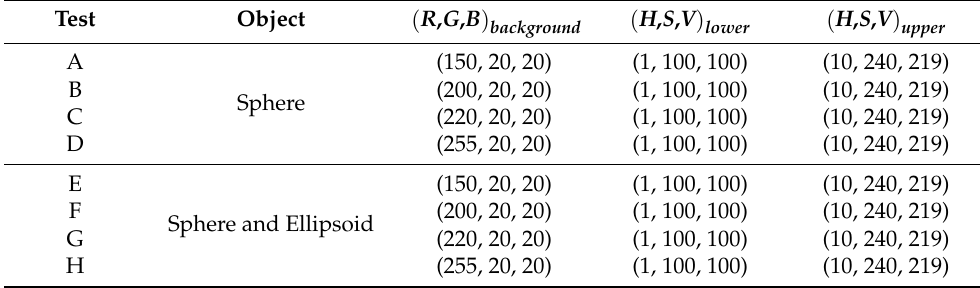
Figure 4. The procedure of image processing: ( a ) capturing the video from the AUV front camera; ( b ) conversion from the RGB color space to the HSV color space; ( c ) histogram equalization, binarization, and filter; ( d ) filter and morphology of dilation and erosion; and ( e ) obtaining the color features of the object. Table 1. The RGB values of the background colors and the HSV threshold values of the